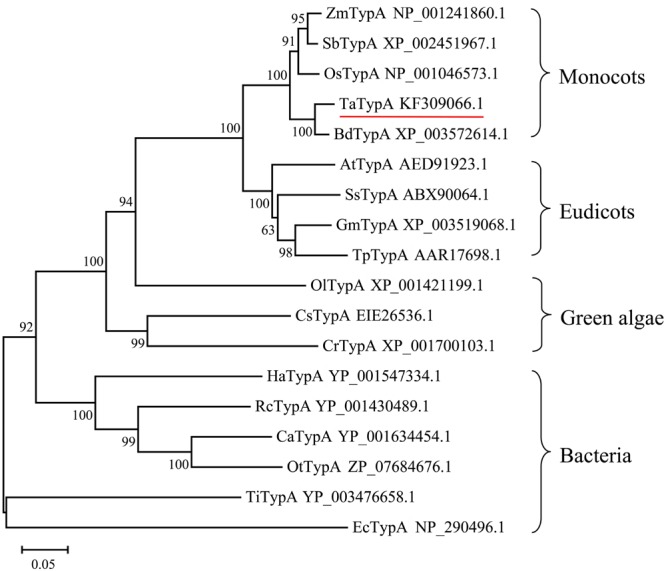
Neighbor-joining tree of TypA protein sequences based on multiple alignments. The number above the internal branches indicates bootstrap values estimated based on 1,000 replications. Scale bar represents the estimated number of amino acid substitutions per site. Branches are labeled with protein names and GenBank accession numbers. Ta, Triticum aestivum; Bd, Brachypodium distachyon; Os, Oryza sativa; Zm, Zea mays; Sb, Sorghum bicolor; Gm, Glycine max; Ss, Suaeda salsa; At, Arabidopsis thaliana; Tp, Trifolium pretense; Ol, Ostreococcus lucimarinus; Cs, Coccomyxa subellipsoidea; Cr, Chlamydomonas reinhardtii; Ca, Chloroflexus aurantiacus; Rc, Roseiflexus castenholzii; Ha, Herpetosiphon aurantiacus; Ot, Oscillochloris trichoides; Ti, Thermoanaerobacter italicus; Ec, Escherichia coli.